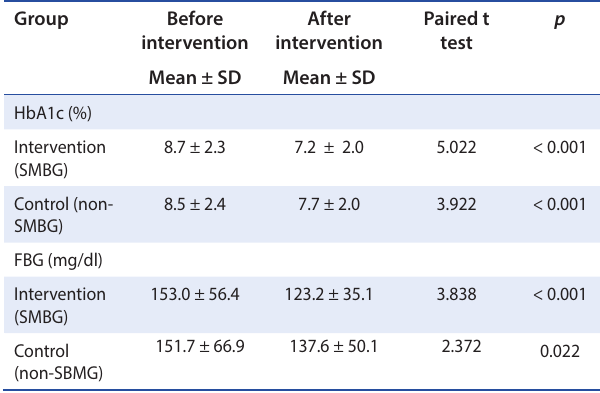
Table 4: HbA1c and FBG before and after intervention in the two groups